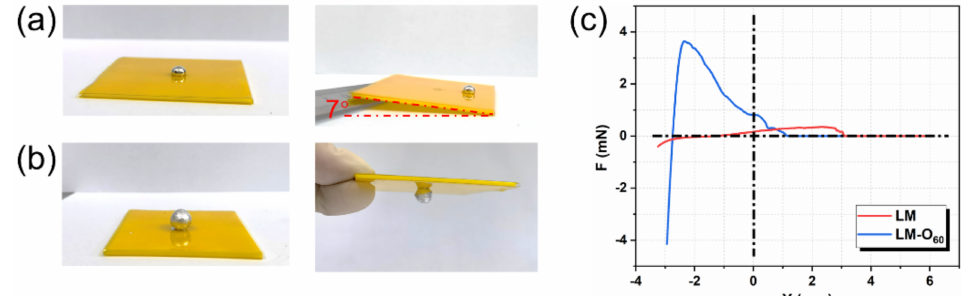
Figure 4. ( a ) The slope experiment of ( a ) pure liquid metal and LM-O 60 ( b ), the radius of the droplet is 5 mm. ( c ) Force–location (F–Y) curves of LM and LM-O 60 with same immersion depth (3.5 mm) under the adhesion force measurement.